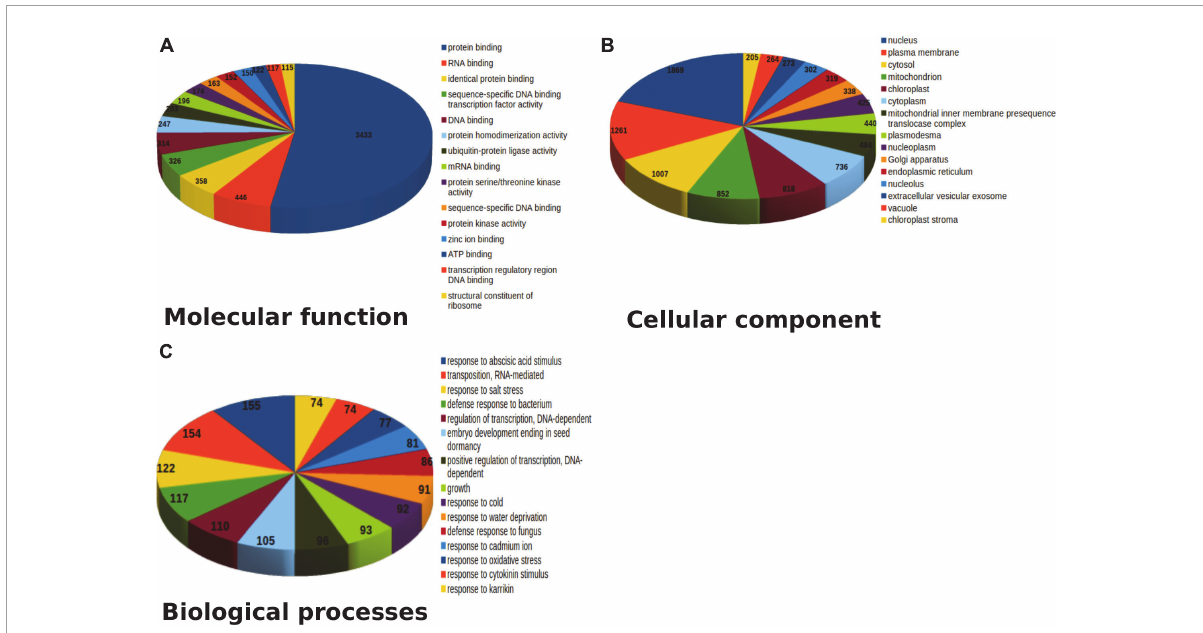
FIGURE4 Eugenol and β -sitosterol content in leaf and pseudobulb of in vitro raised M. acuminata. Value in the bar represents mean of three independent biological replicates with standard error of mean.